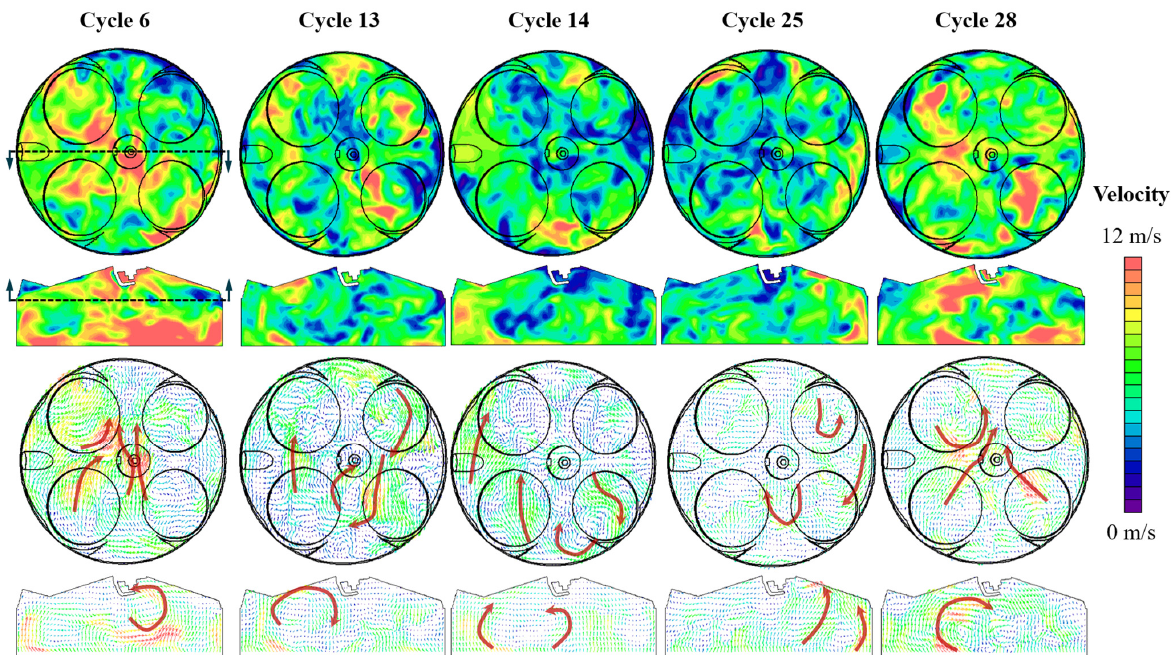
Figure 12. Distributions of flow velocity magnitude and vectors at 670 °CA.